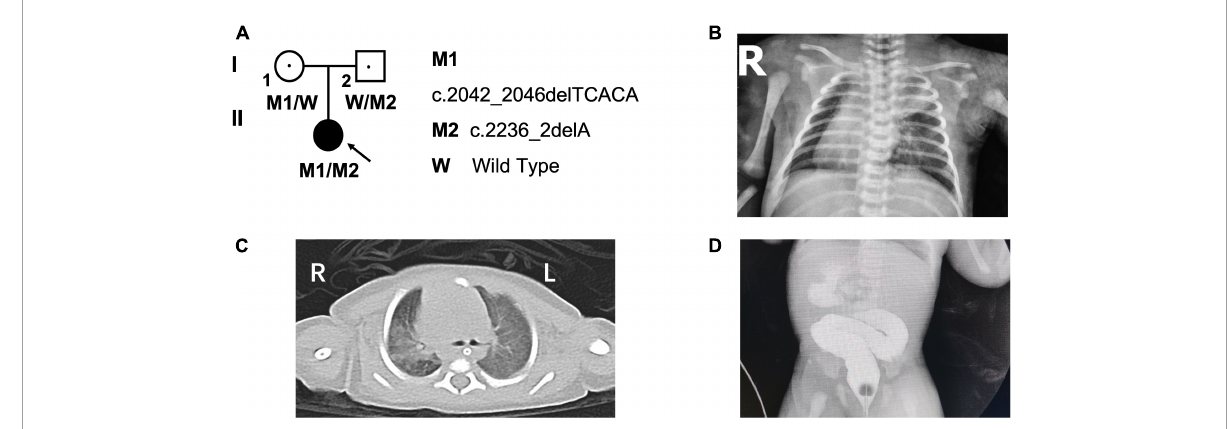
FIGURE1 Pedigree of the family and the clinical photographs of the proband. (A) The pedigree of the patient’s family. (B) The chest radiography and (C) computed tomography scan indicated situs inversus and bronchopneumonia. (D) The gastrointestinal contrast indicated duodenal obstruction. L, left; R, right; “blue arrow” showing bronchopneumonia; “red arrow” showing the location of duodenal obstruction.